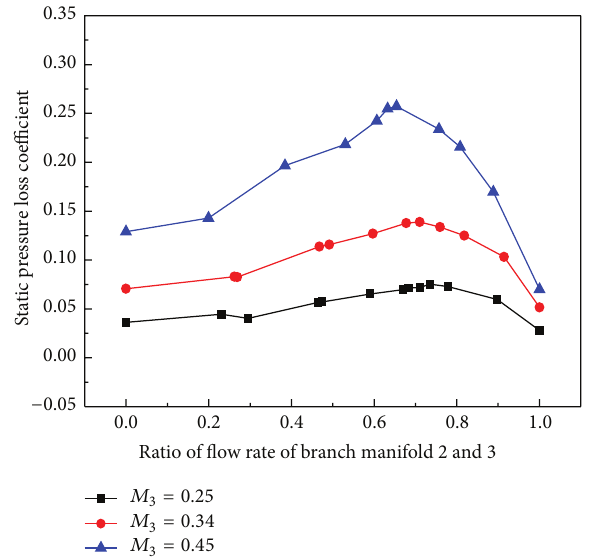
Figure 10: Static pressure loss coefficient from branch manifold 2 to branch manifold 3.